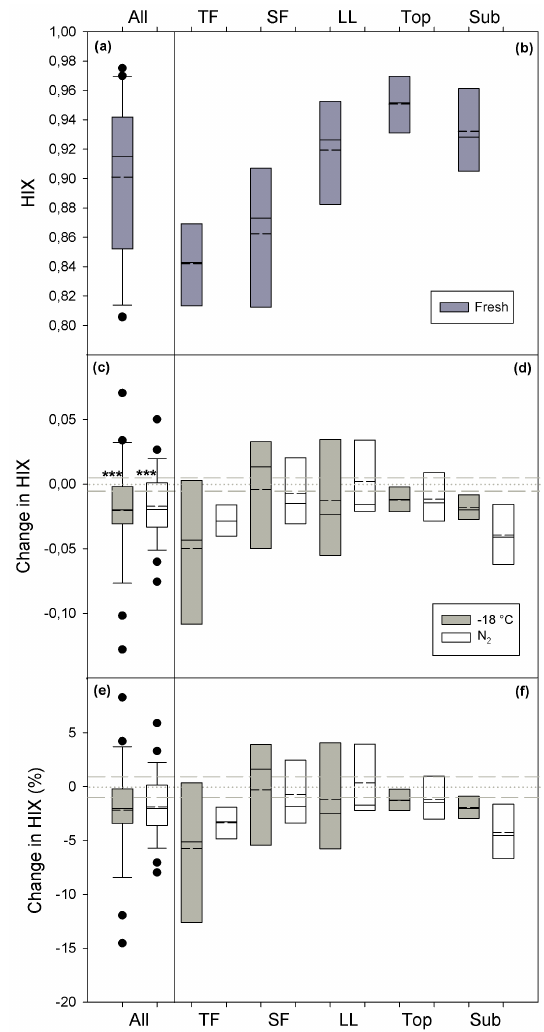
Figure 4. Absolute values (measured in fresh samples) and changes of SUVA254 after freezing ( − 18 ◦ C) and fast-freezing with liquid nitrogen; (a, c, e) all samples ( n = 27); (b, d, f) ordered by sample type (throughfall (TF) n = 6, stemflow (SF) n = 5, litter leachate (LL) n = 5, top soil solution (Top) n = 6, sub-soil solution (Sub) n = 5); gray dashed line: analytical reproducibility; ∗∗∗ significant changes (linear mixed models (lme), p< 0.05); boxplots: solid line: median, dashed line: mean.